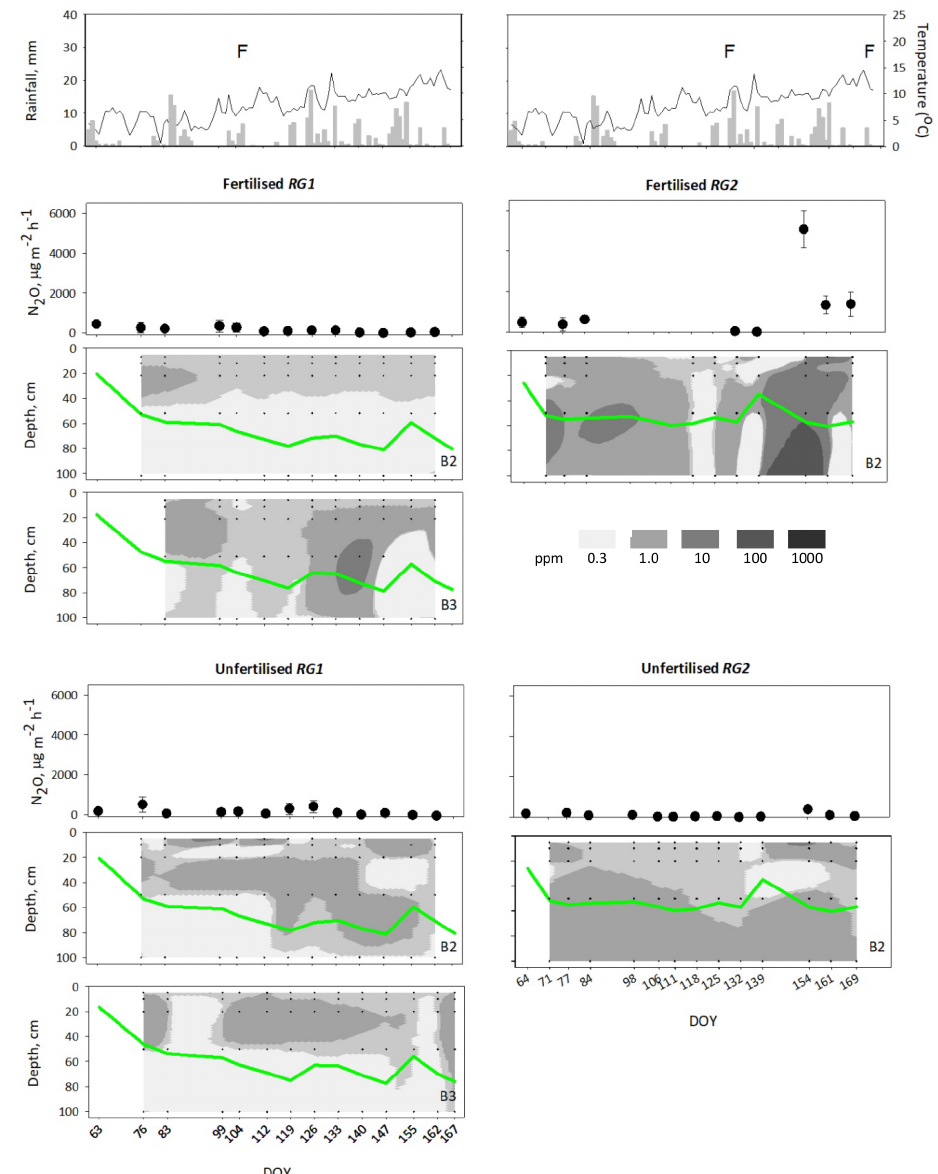
Figure 3. The top panel shows rainfall, air temperature and management ( F – fertilisation) at RG1 (left panels) and RG2 (right panels) during spring, 3 March (DOY 63) to 16 June (DOY 169). The middle section shows N 2 O fluxes (black circles; mean ± standard error, n = 3) and contour plots of soil N 2 O concentrations in fertilised subplots, and the lower section shows the corresponding results for unfertilised subplots. A logarithmic grey scale was used in order to show trends within both RG and AR treatments and between depths. Soil gas sampling positions are indicated in the contour plots; numbers shown are N 2 O concentrations (µLL − 1 ). Green lines show the WT depth (which varied slightly between blocks). B2 and B3 refer to block number of diffusion probe